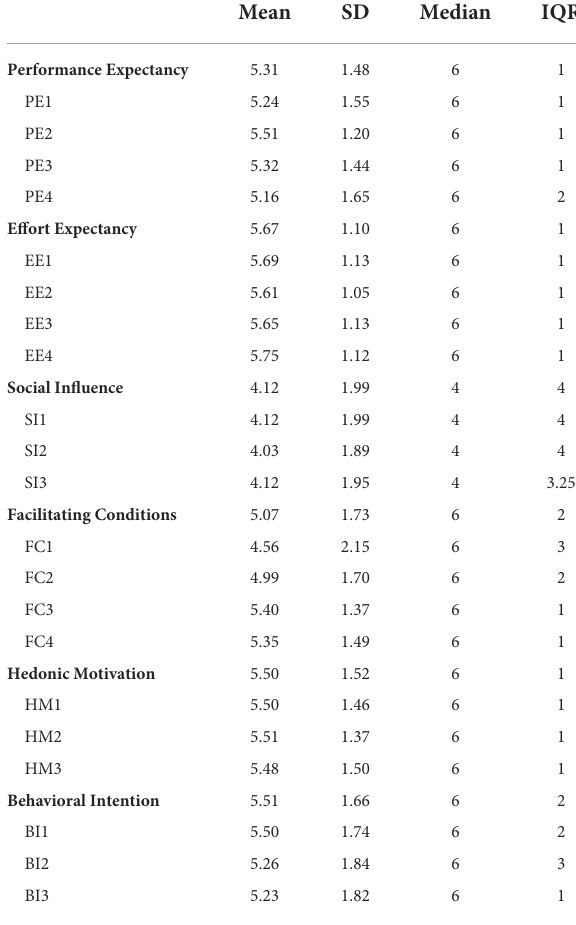
TABLE 3 Descriptive statistics for the constructs and